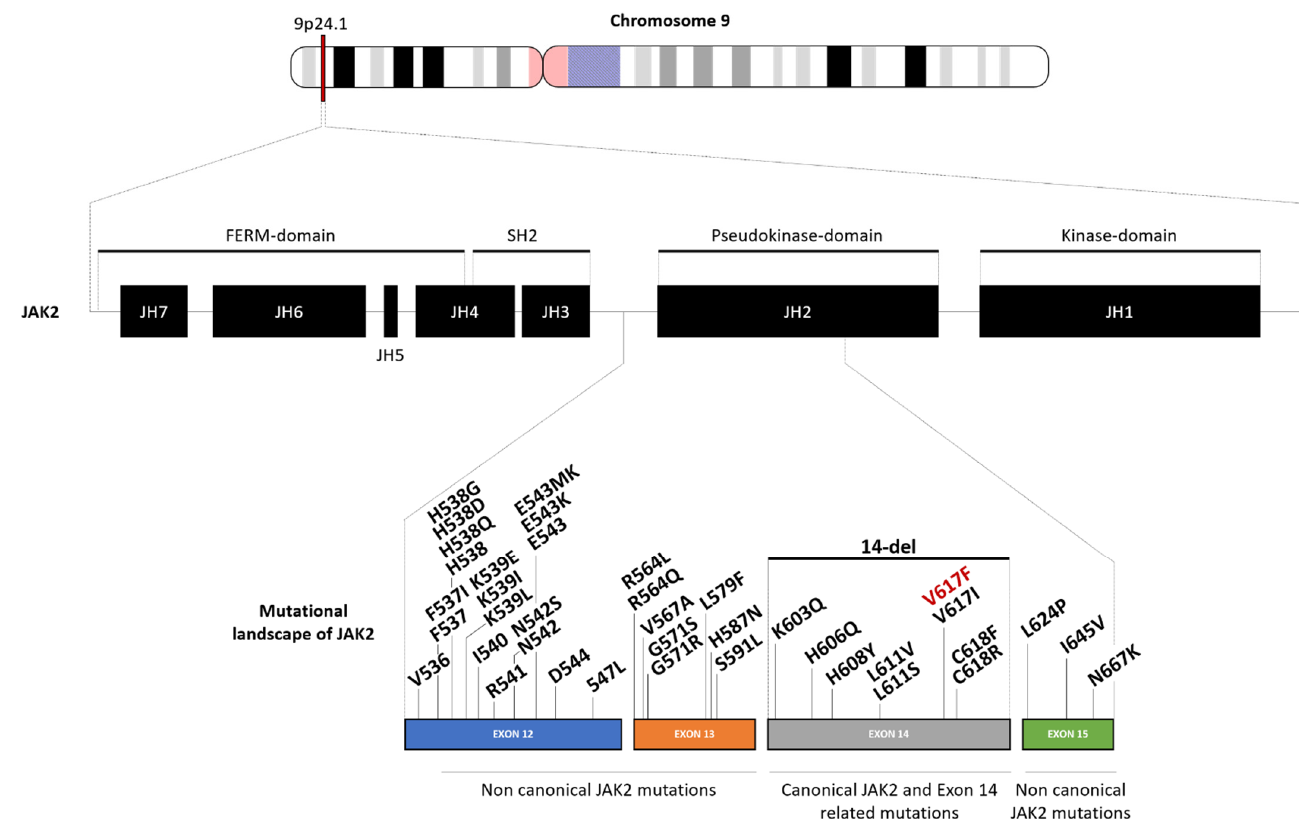
Figure 1. Schematic view of JAK2 gene structure and its mutational landscape in PV. JAK2 gene is found on chromosome 9 at 9p24.1 (4,984,390–5,129,948) location. It is composed of 7 homology do ‐ mains (JH1 to JH7) that correlate to 4 functional domains: FERM, SH2, Pseudokinase, and Kinase domains. In PV, the mutations affected the region of JAK2 span from exon 12 to exon 15 and mainly belong to the JH2/Pseudokinase ‐ domain. Abbreviation: del = deletion; FERM = four ‐ point ‐ one, ezrin, radixin, moesin; JH = Jak homology region; SH2 = src homology 2 domain. Table 1. Summary of canonical and atypical JAK2 mutations in PV. NB: 96% to 99% of patients that suffer from PV are JAK2 mutated. Canonical/Non Canonical